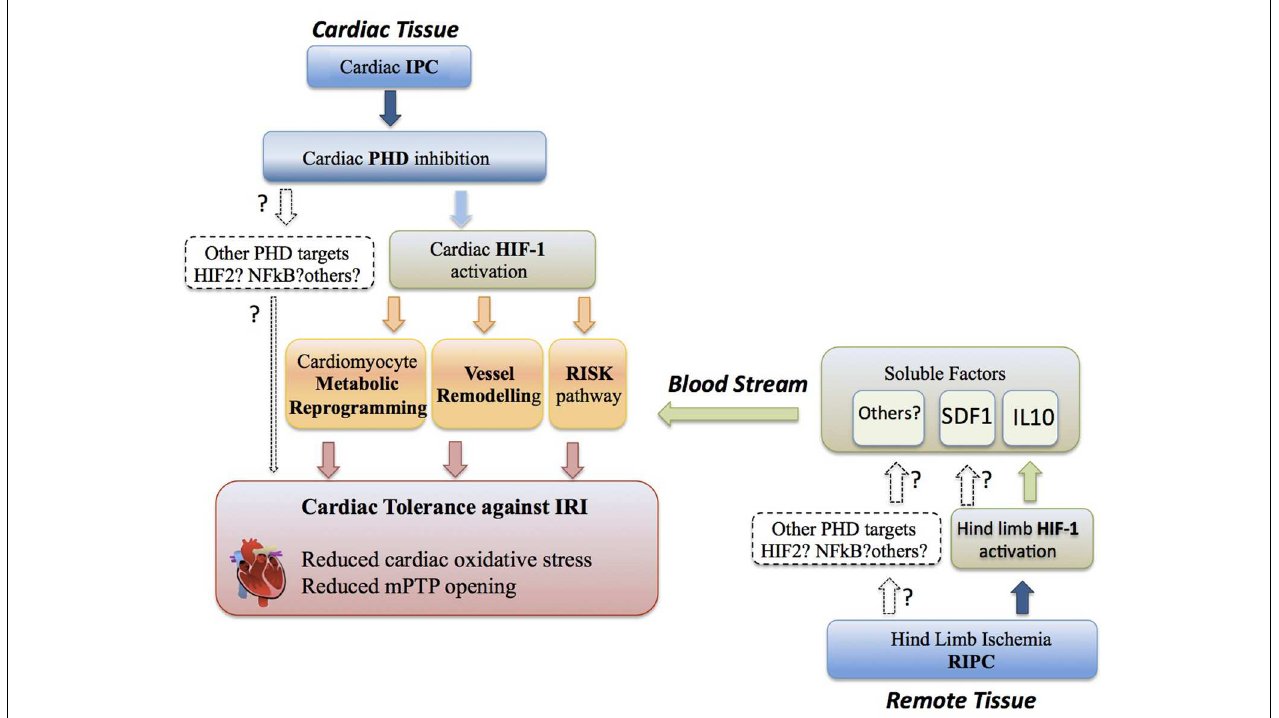
FIGURE 1 | Cardioprotection through the PHD-HIF pathway. Cardiac tolerance against IRI (ischemia reperfusion injury) can be initiated by HIF1 α activation locally in the cardiac tissue during IPC (ischemia preconditioning). IPC in the heart leads to cardiac PHD inhibition and subsequent induction of a HIF1 α -dependent cardiac metabolic reprogramming, vessel remodeling and activation of the RISK pathway, which ultimately results in reduced cardiac oxidative stress, prevention of mitochondrial permeability transition pore (mPTP) opening and cardiac tissue salvage. The potential role of alternative PHD targets in IPC